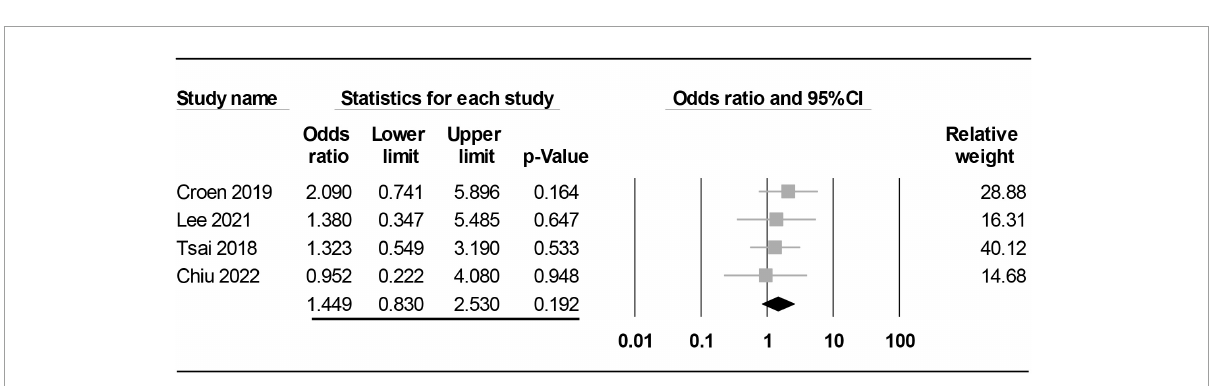
FIGURE5 Forest plot showing association between maternal diagnosis of rheumatoid arthritis (RA) before childbirth and risk of offspring autism spectrum disorder (ASD). CI, confidence interval.